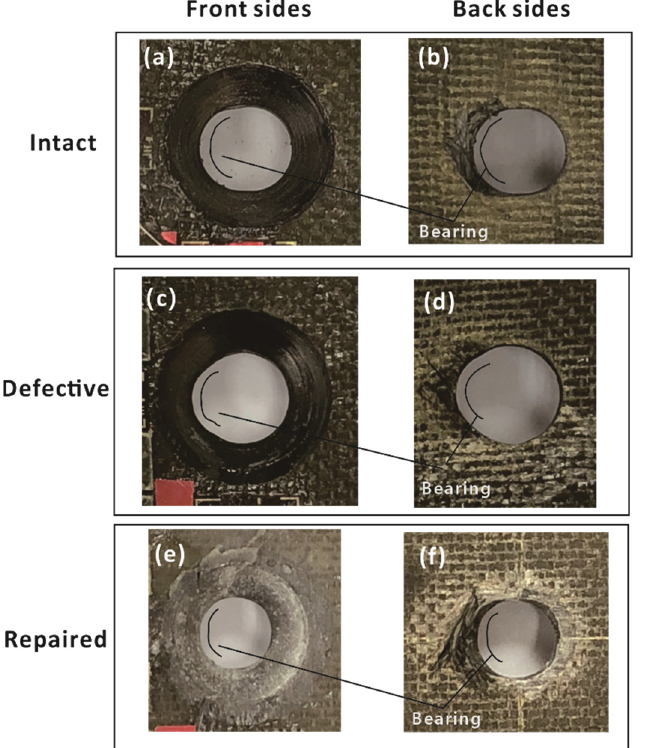
Figure 8. Failure modes of intact, defective and repaired samples. Front sides of (a) intact, (c) defective and (e) repaired samples; back sides of (b) intact, (d) defective and (f) repaired samples. and ( e ) repaired samples; back sides of ( b ) intact, ( d ) defective and ( f ) repaired